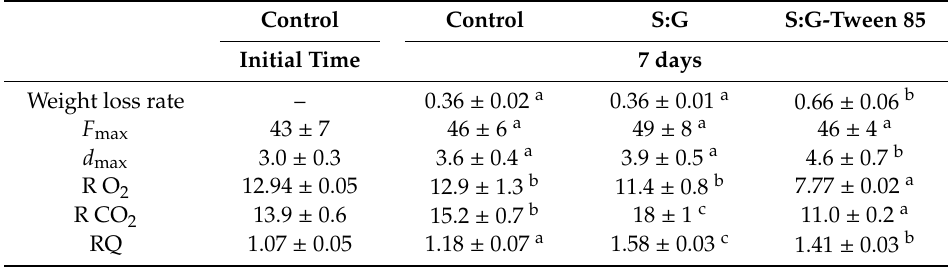
Di ff erent superscript letters within the same row indicate significant di ff erences among CFS according to Fisher’s LSD test ( p <